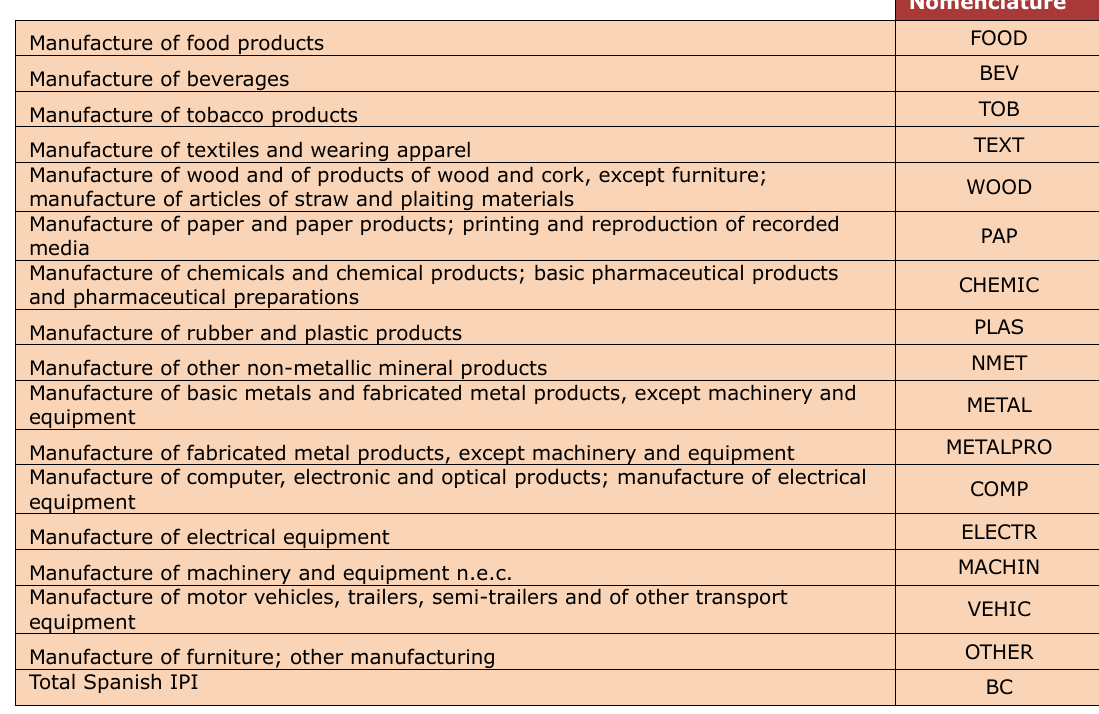
Table 1. Manufacturing